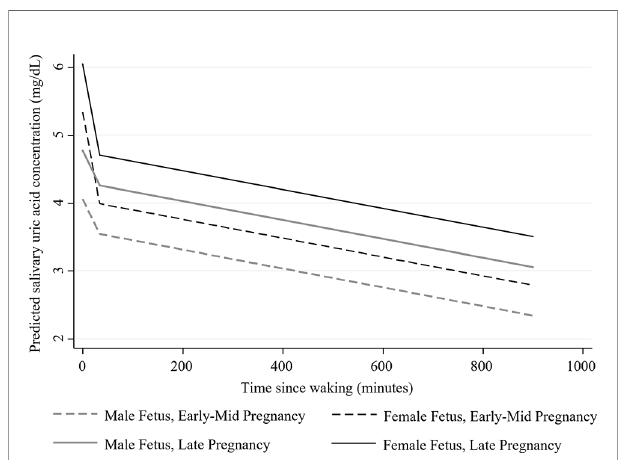
FIGURE 2 | Estimated adjusted diurnal concentrations of salivary uric acid (mg/dL) during early-mid and late pregnancy among women carrying male and female fetuses ( N =43). Data were collected on two days in early-mid (5- 21 weeks gestation; shown in dotted lines) and two days in late pregnancy (30-34 weeks gestation; shown solid lines). Estimates were generated from the fully adjusted model for salivary uric acid. See Table 2 for the covariates included in this